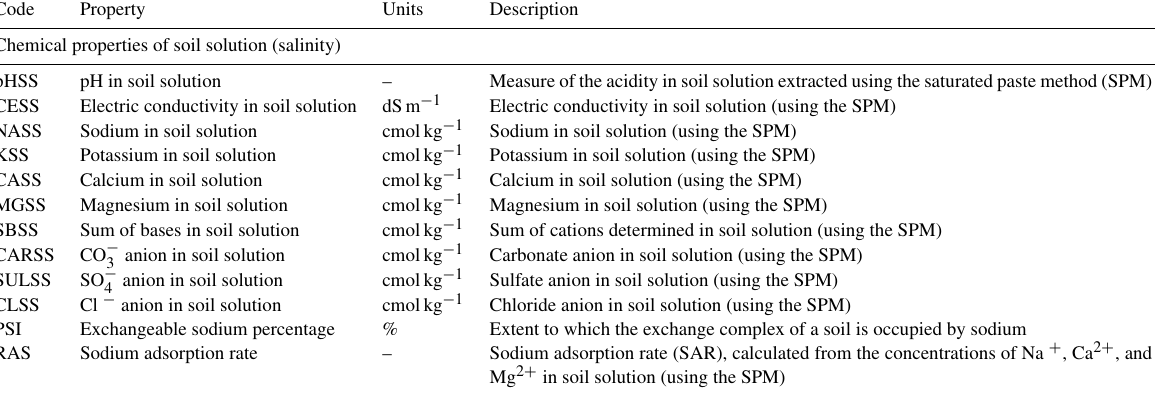
Table 3. Statistical analysis of key variables in the HESD. The two most nationally representative types of ecosystems were selected: cropland (9675 data points) and forest (3694 data points).